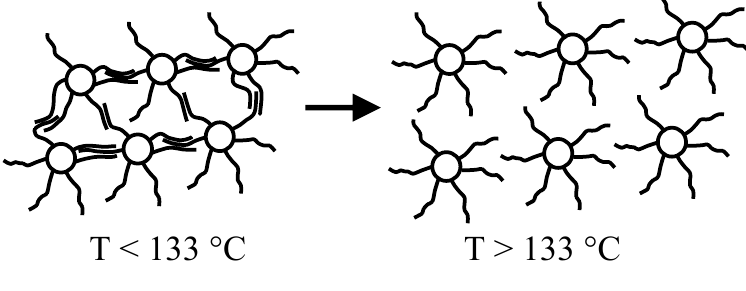
Figure 2. Schematic representation of the crystallization by interdigitation for nano- particles of silver capped by